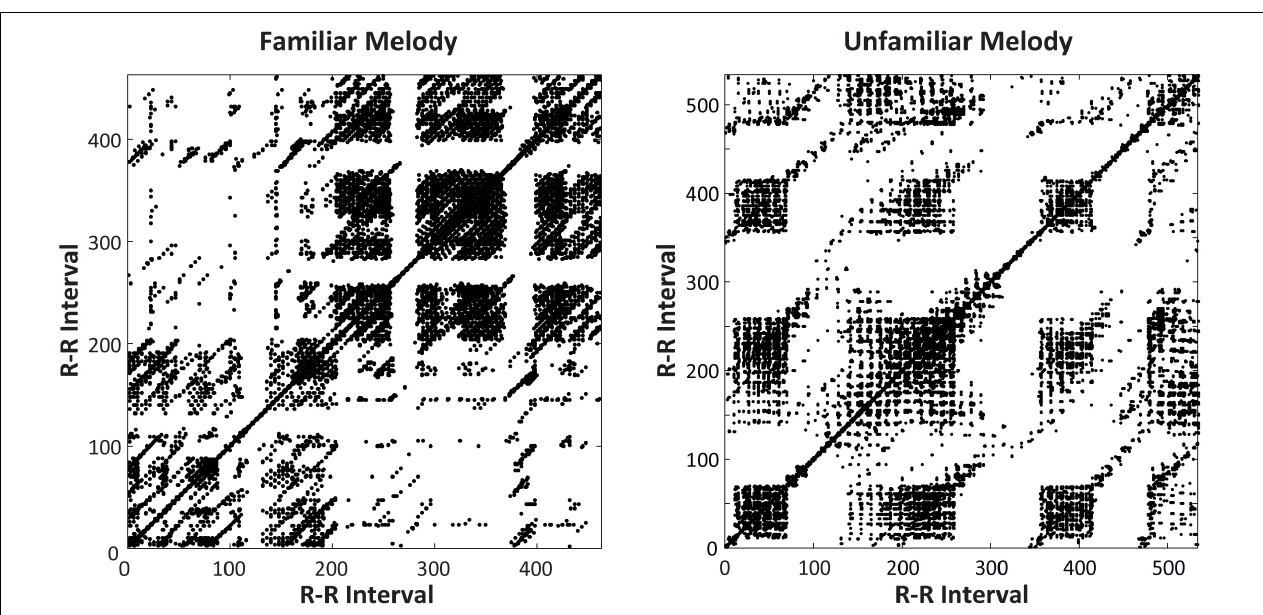
FIGURE 7 | Recurrence plots for a single participant’s heartbeat series (RR intervals, in ms, plotted on x - and y -axes) at 13 h. Plots include Familiar melody performance (left) and Unfamiliar melody performance (right) . The Unfamiliar melody performance showed greater Determinism (=53.31%) than did the Familiar melody performance (=